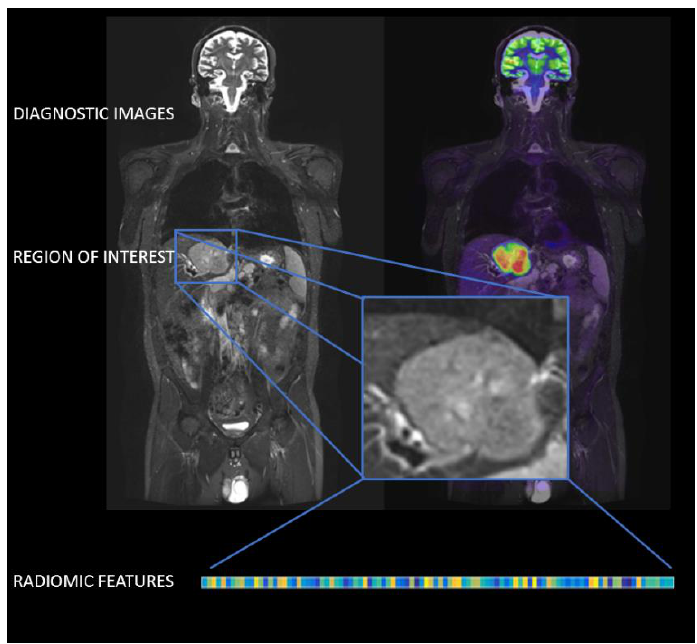
Figure 2. Radiomics workflow. The image shows the three main steps involved in the estimation of radiomic features: magnetic resonance (MR) image acquisition, definition of regions of interest (ROIs), and extraction of numerical descriptors (radiomic features).